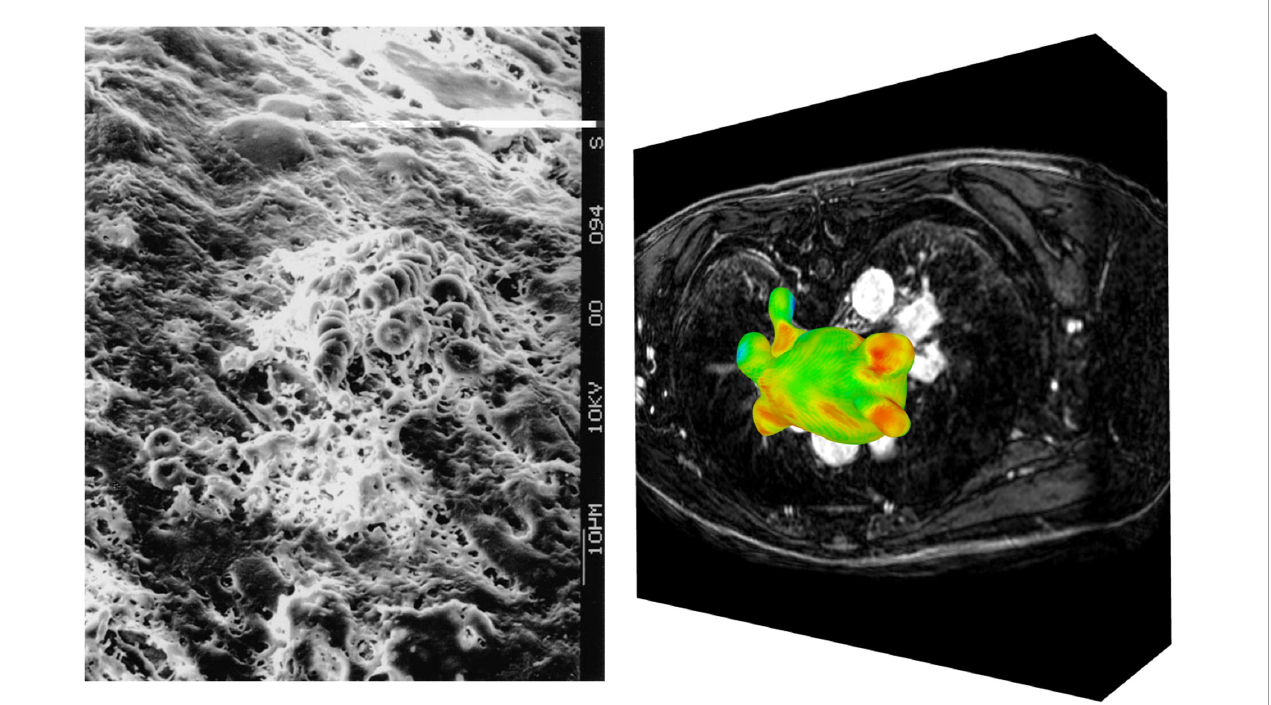
FIGURE3 Imaging of endothelial damage. Scanning electron microscopy of a fibrin and erythrocyte rich clot formed in the LAA (left) (49). Visualisation of raw LGE intensity map derived from LGE-CMR image stack (right) .